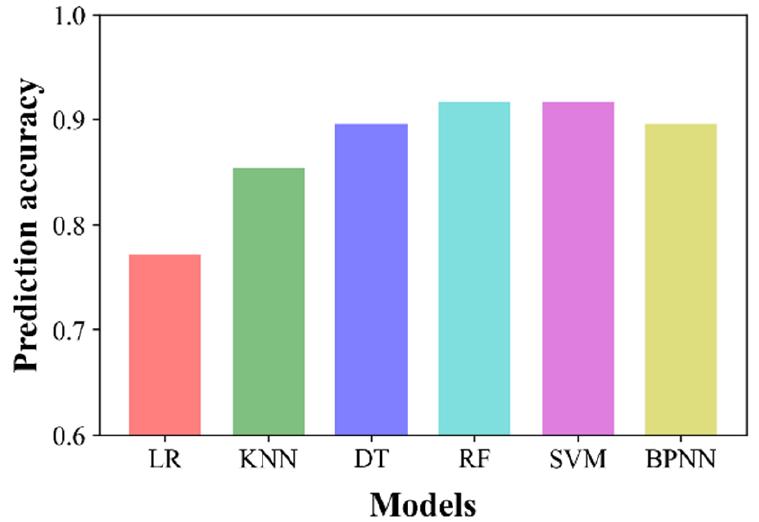
Figure 8. Prediction accuracy results of the six ML models. Both RF and SVM yielded the highest accuracy of 0.917.